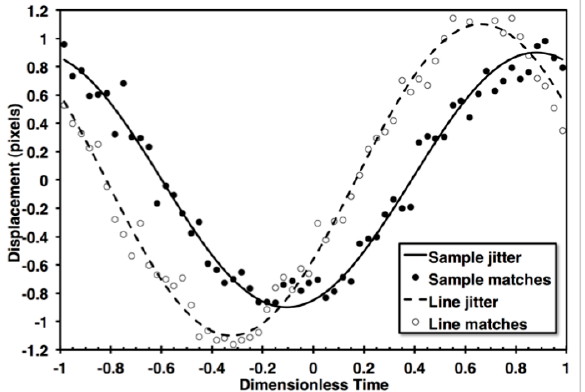
Figure 6. Jitter displacements used to resample the “truth” image for the tests described here and the displacements recovered by matching check lines to the image. Time has been scaled to run from -1 to 1 over the readout